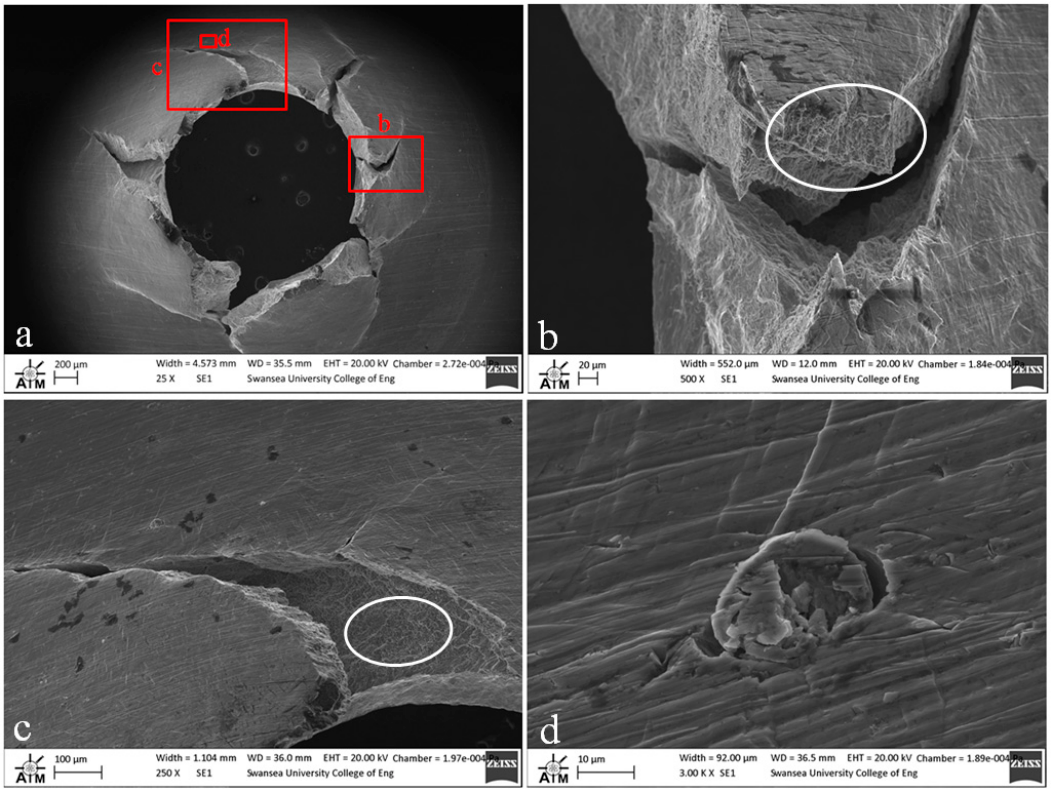
Figure 14. SEM images of fractured SP disc of the EBM Ti-6Al-4V material showing ( a ) overall fracture surface; ( b ) typical rupture behaviour; ( c ) separation of melt layers and ( d ) processing anomaly.